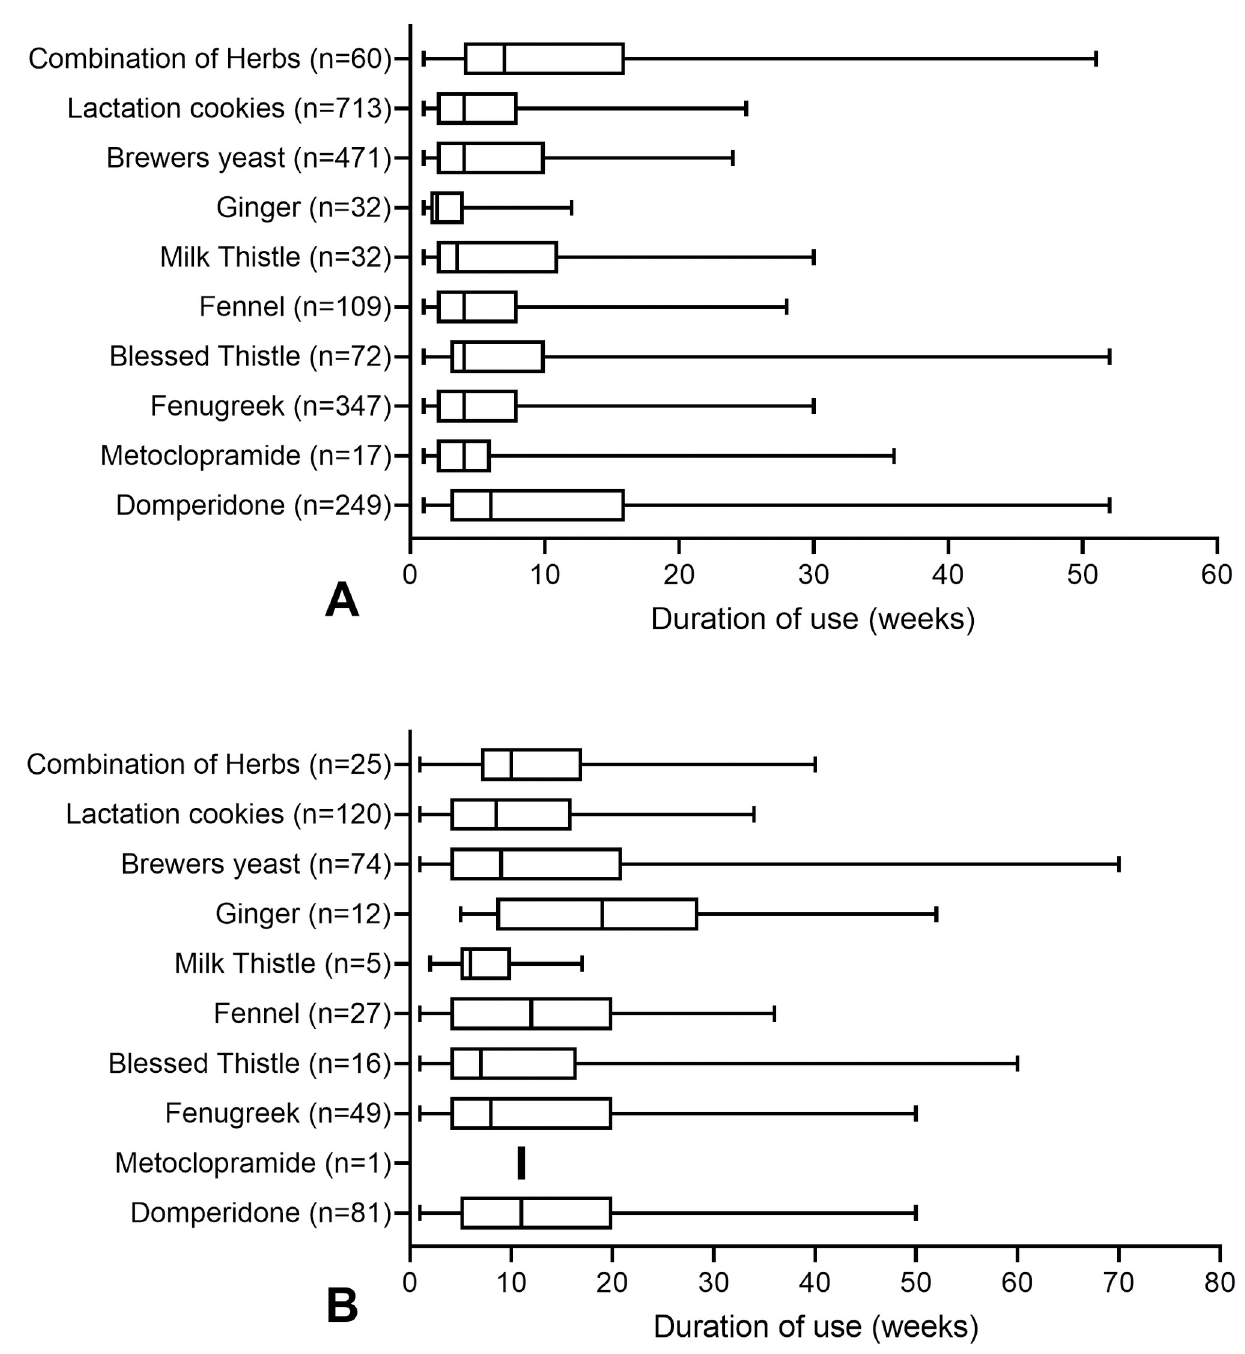
Fig 4. Duration of galactagogue use by women who had (a) stopped use and those who are (b) continuing use at the time of survey completion (median, inter-quartile range, and 5 th to 95 th percentile whiskers).